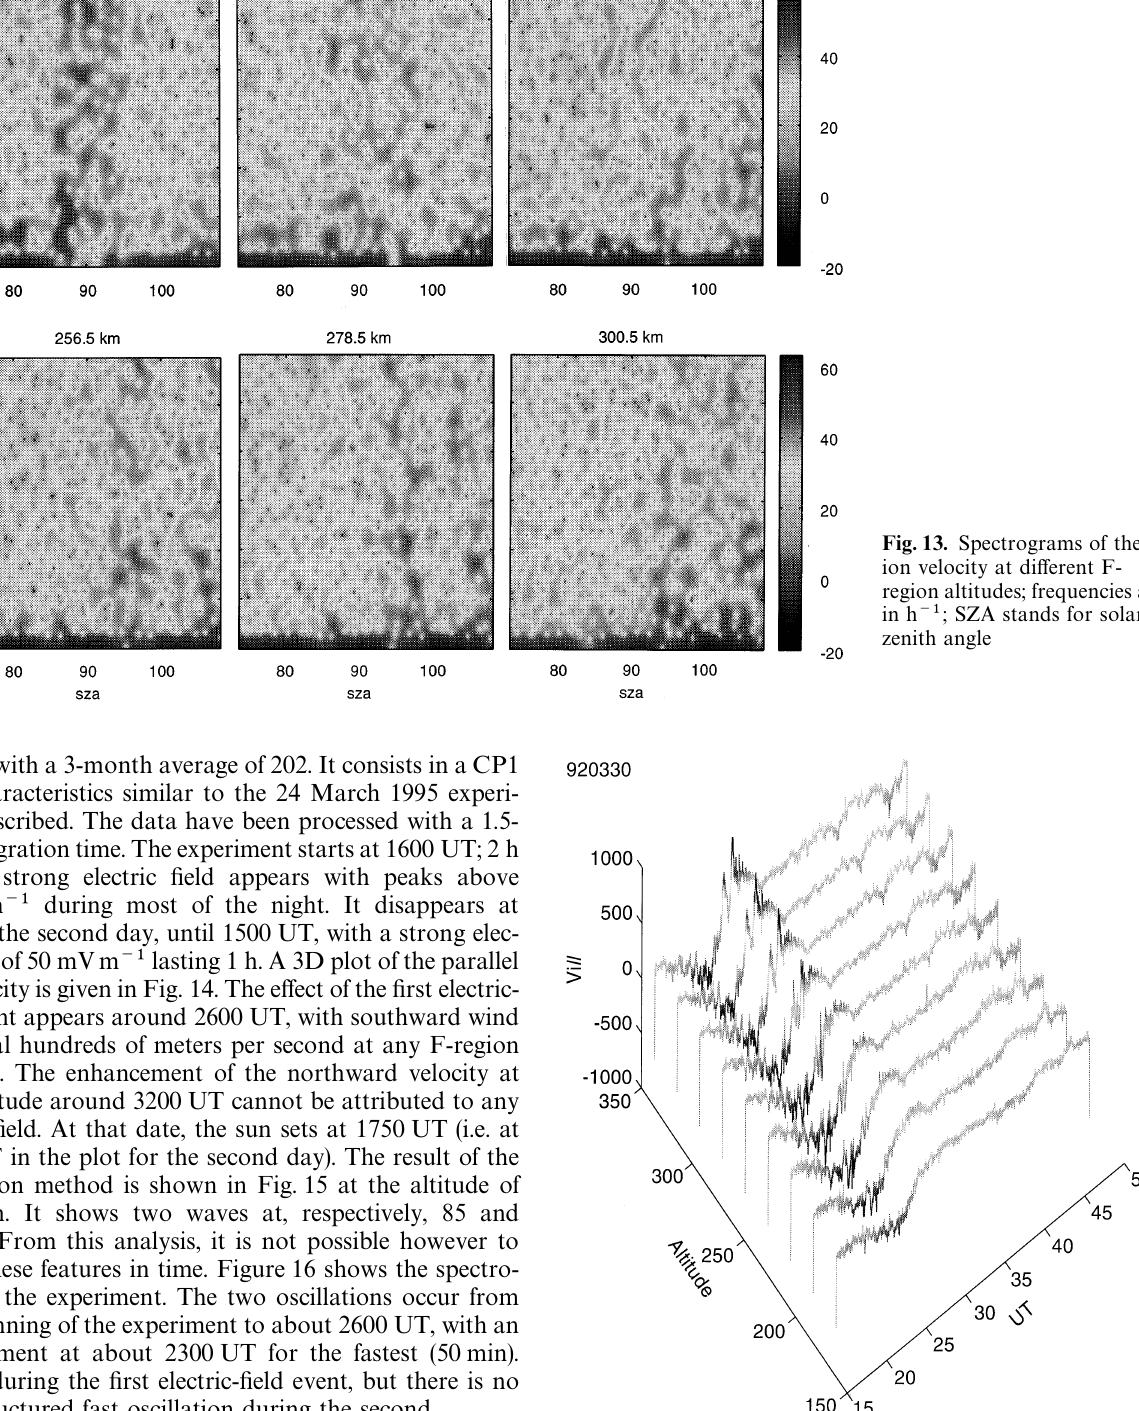
Fig. 14. Overview of the 30 March 1992 parallel ion velocity; alti- tudes are in km and the velocity in ms